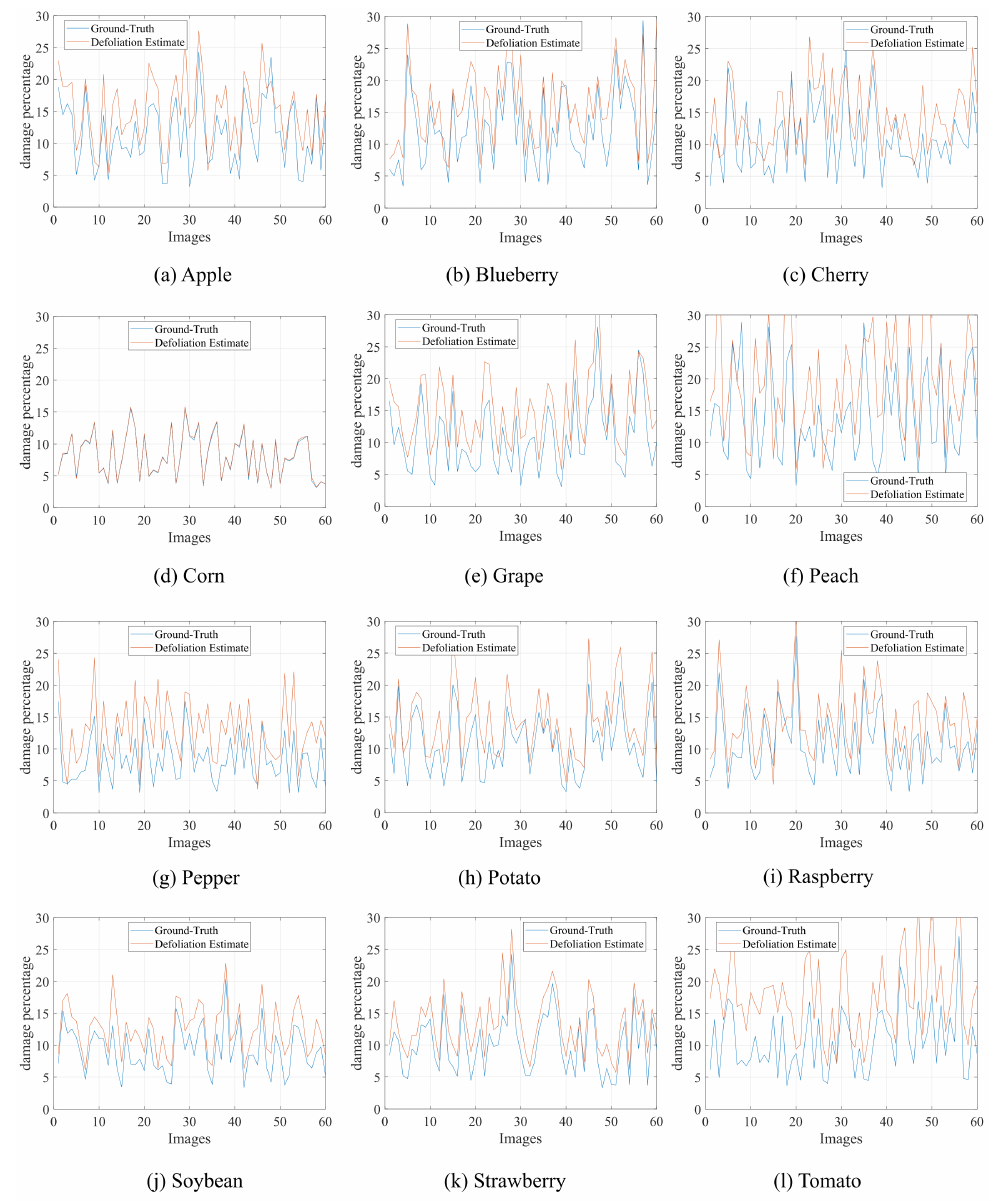
Figure 5. Comparison between ground-truth defoliation levels and estimated damage by our method in different plant